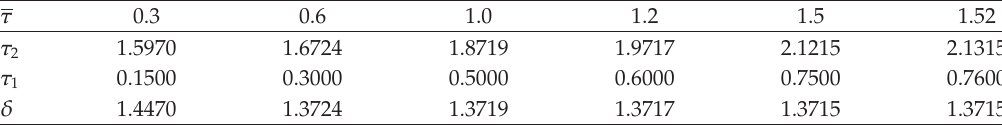
Table 1: Allowable lower bounds and upper bounds for di ff erent τ